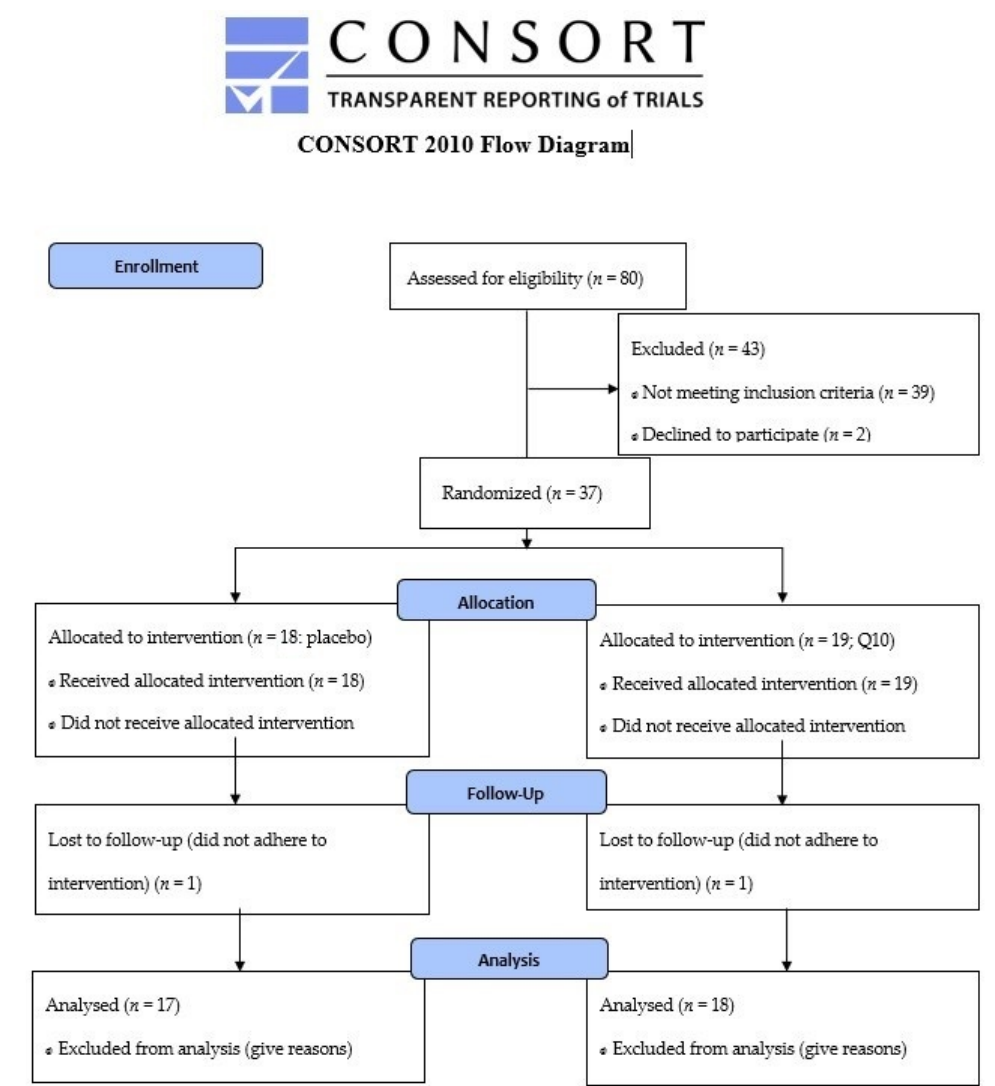
Figure 1. CONSORT 2010 Flow Diagram.